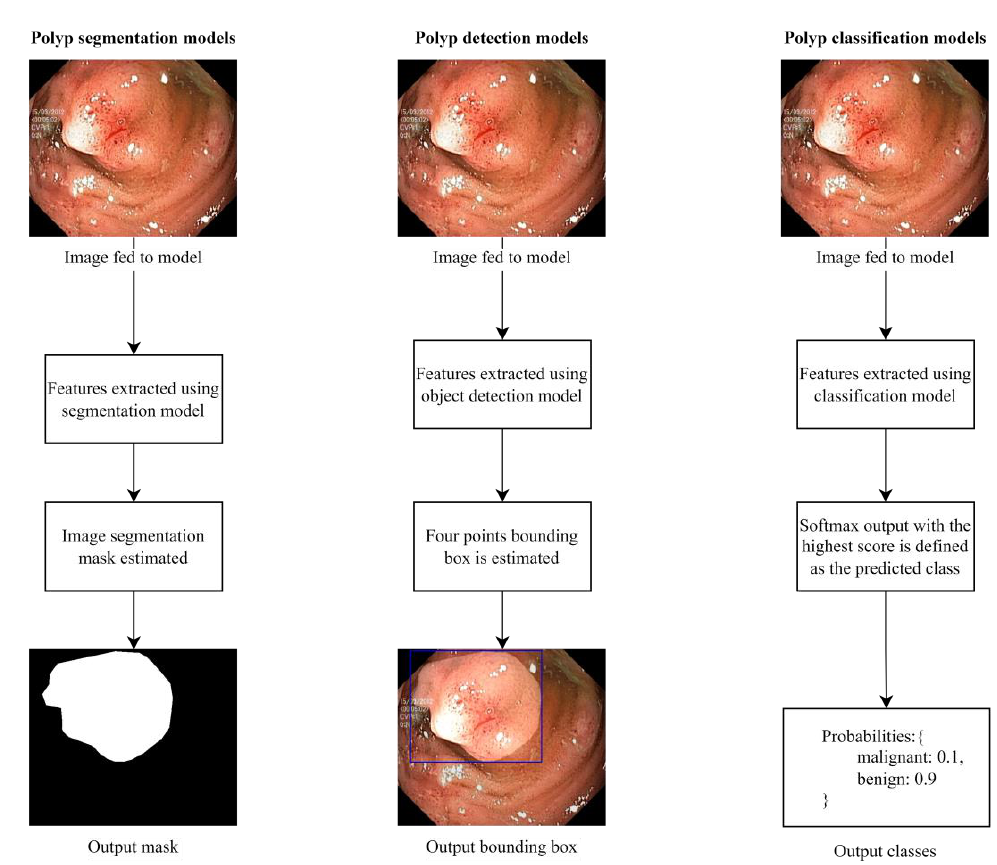
Figure 1. A comparison of the three common approaches to building colorectal polyp detectors. Colonoscopy images are taken from a public dataset known as Kvasir-SEG.